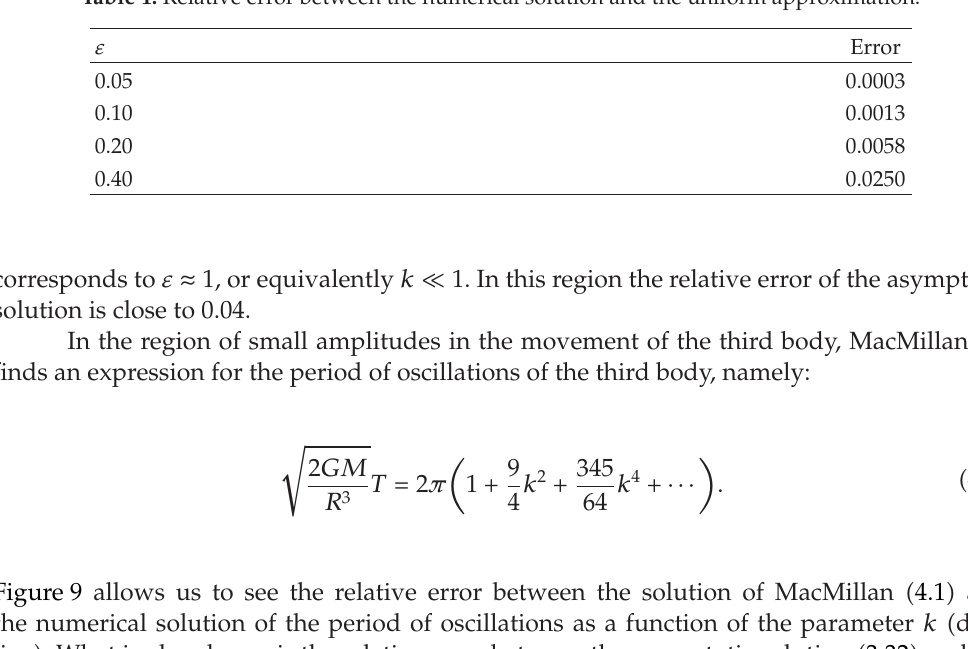
Table 1: Relative error between the numerical solution and the uniform